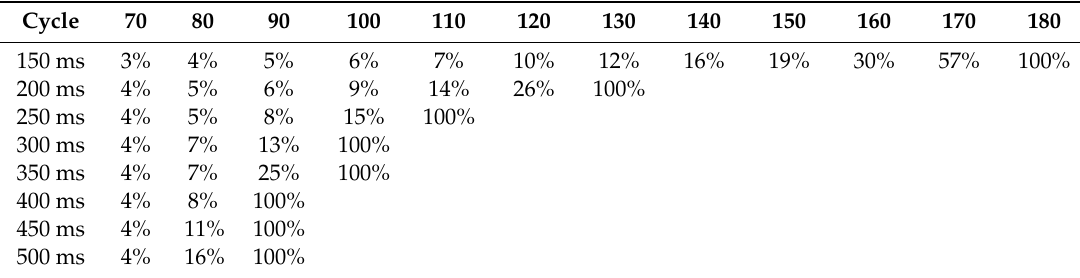
Table 9. Controller area network (CAN) message reception rate with